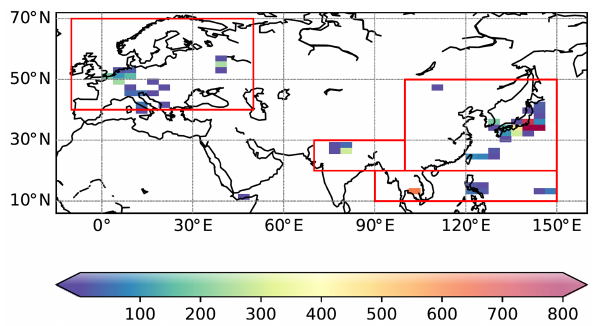
Figure 2. Number of CONTRAIL measurements used here at 5.5km above sea level, within the model grid boxes (3 . 75 ◦ × 1 . 90 ◦ ). The specific areas of Fig. 1 are also shown. Prior to the calculation of this number, the measurements were averaged hourly in each grid